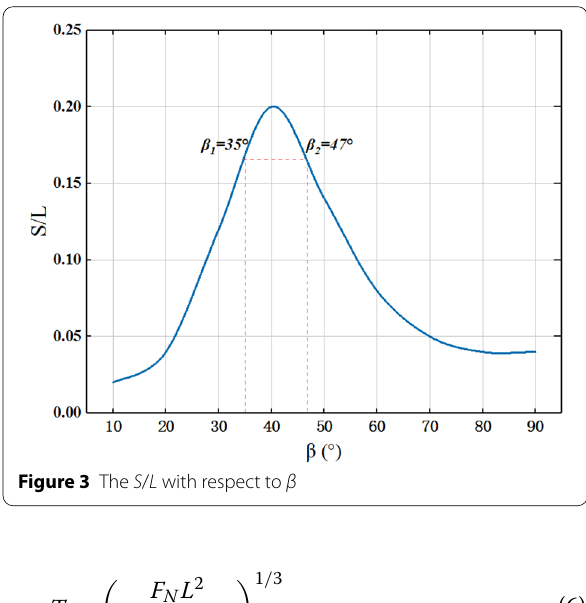
Figure 3 The S / L with respect to